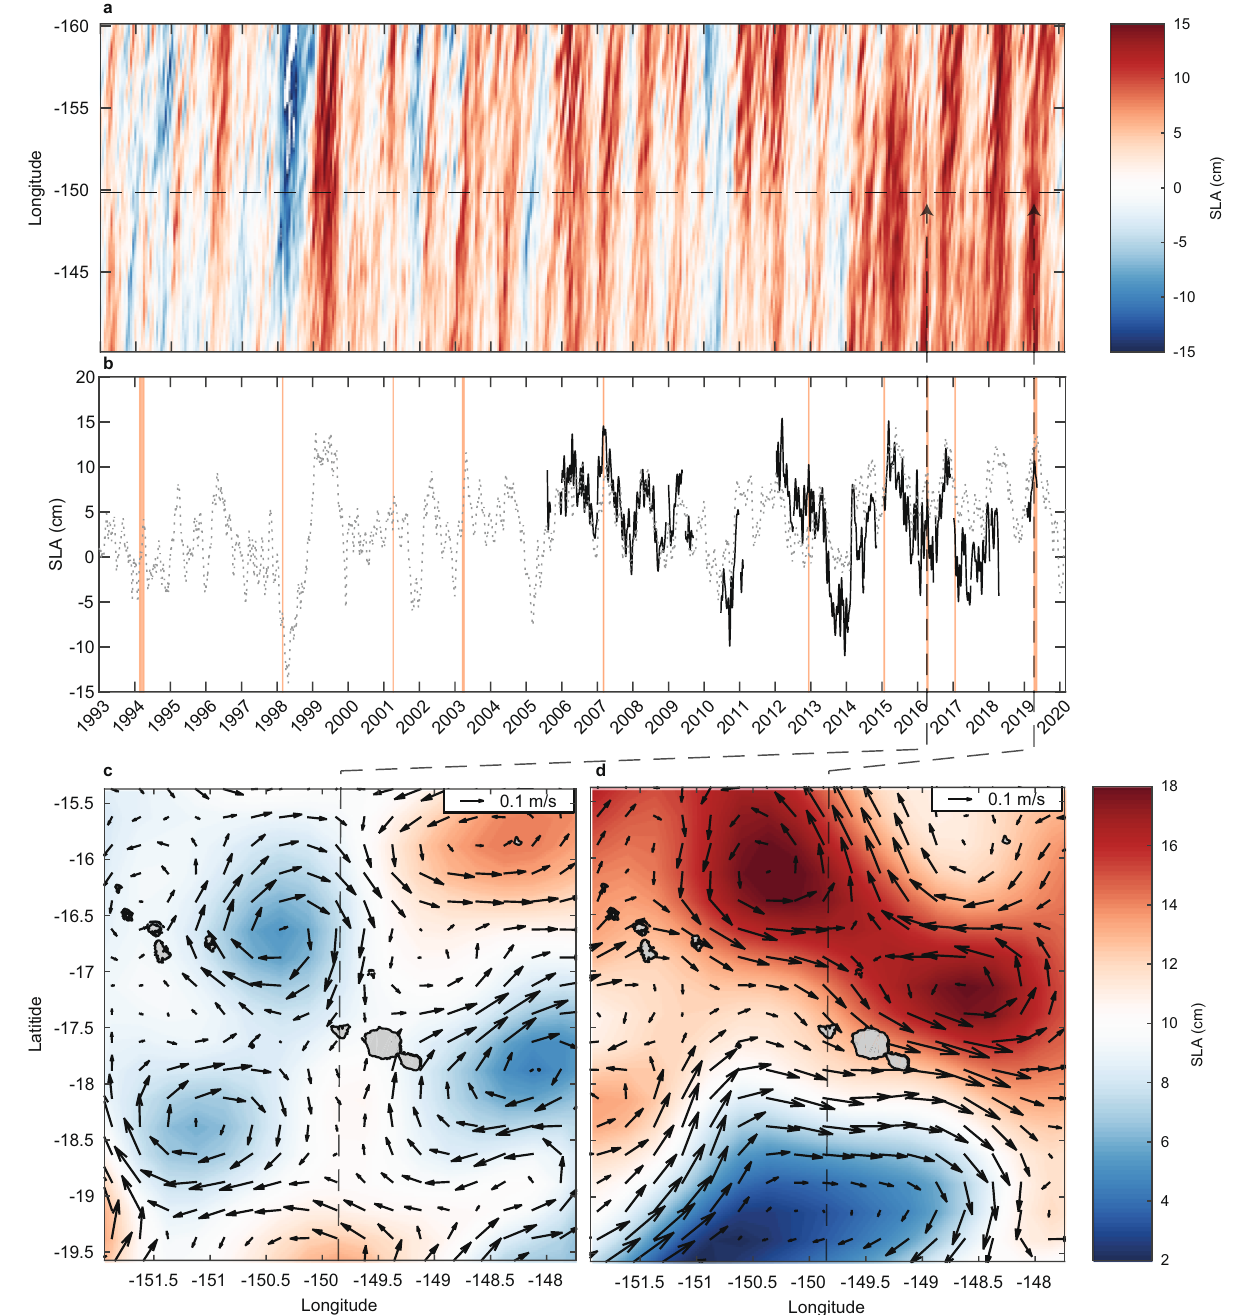
Fig. 6 | The propagation of mesoscale sea level anomalies (SLAs) around Moorea highlighting contrasting eddy fi elds during the 2016 and 2019 marine heatwaves(MHWs). Satellite altimetryshows a thelong-termtrendsinSLAsalong the latitude of Moorea ( − 17.5°; horizontal dashed line indicates longitude of − 149.83°) and b changes in SLAs north of Moorea (dotted grey line) relative to in- situ SLAs measured at 10m depth over the north shore fore reef (solid black line). c Lower SLA and a cyclonic eddy north of Moorea in 2016 contrasts with d higher